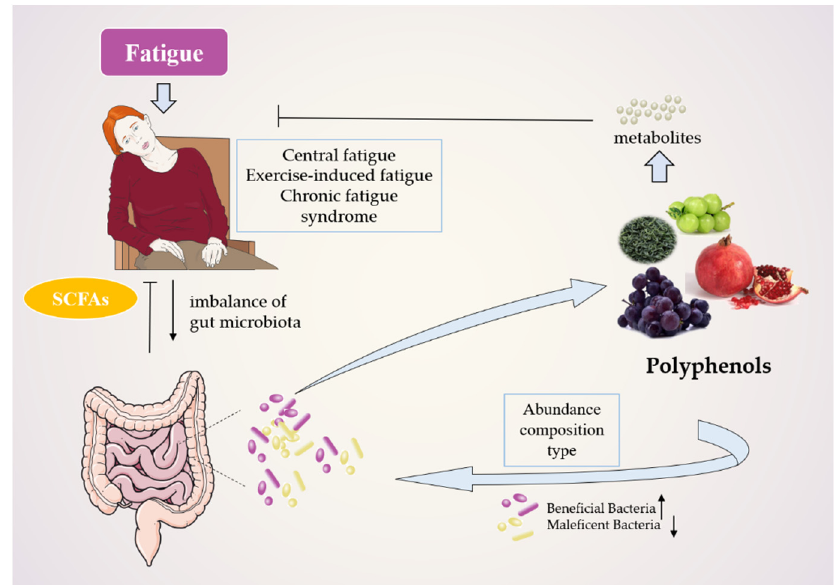
Figure 2. Occurrence and treatment of fatigue: interaction of polyphenols, host, and gut microbiome.